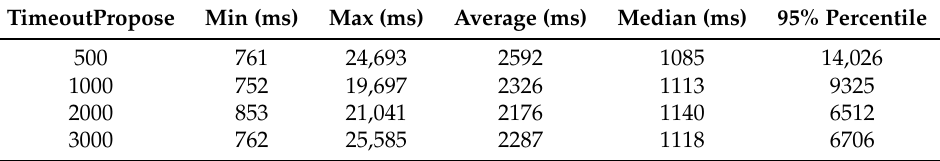
Table 9. Network latency with 32 producer nodes under failure assumption.